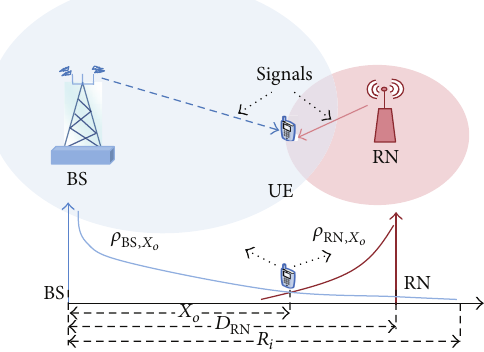
Figure 3: Hand over